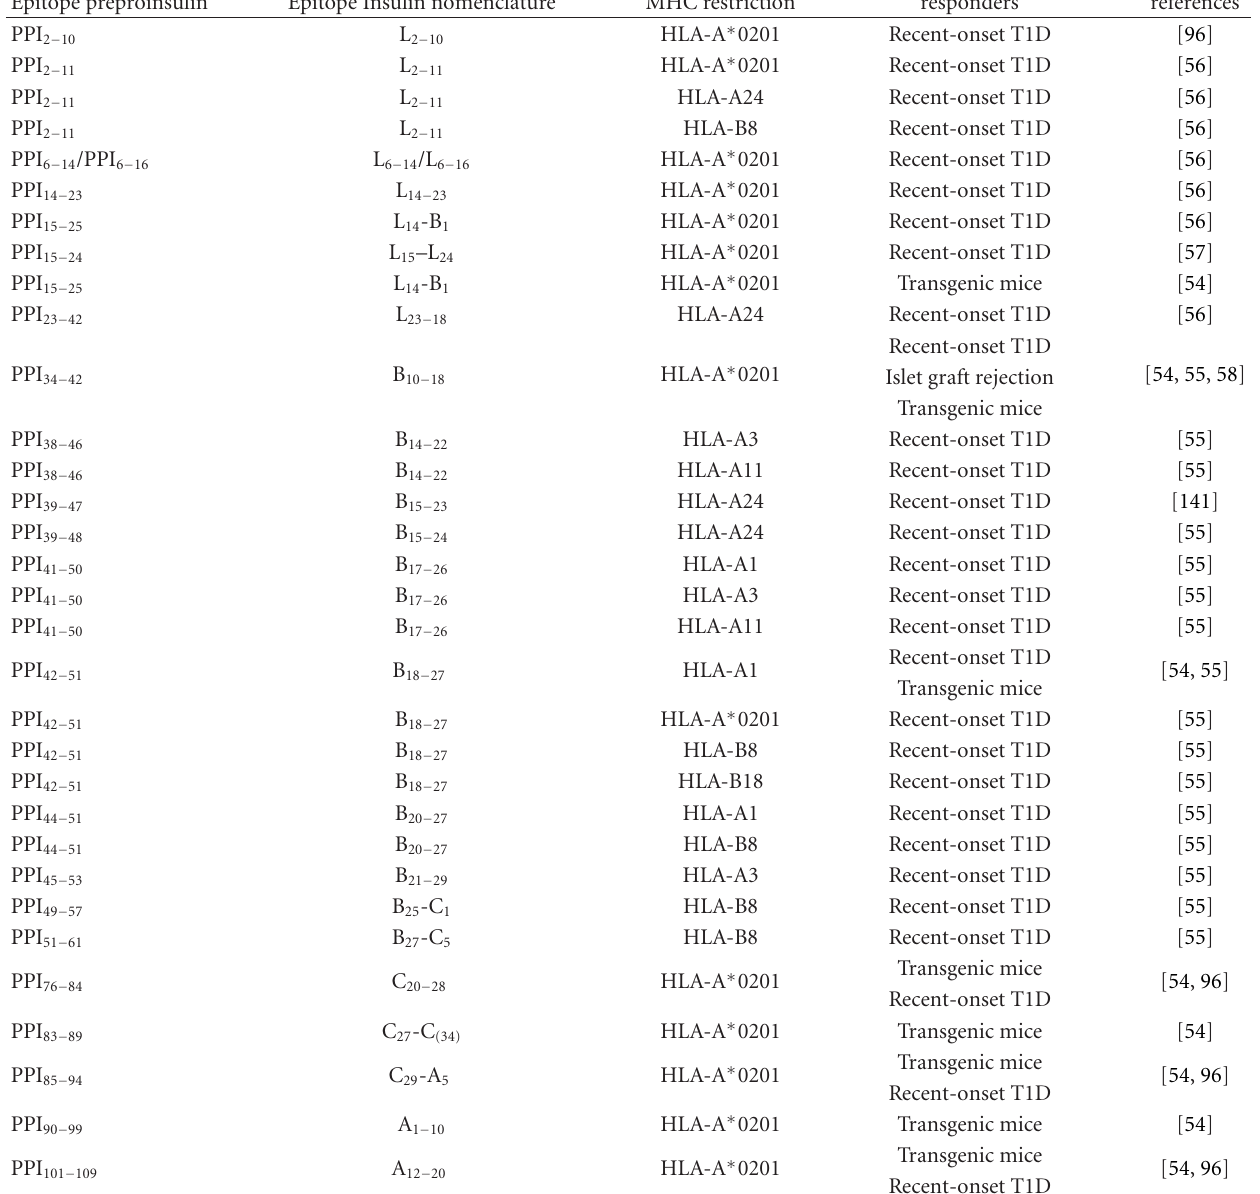
Table 3: CD8 + T-cell epitopes on human